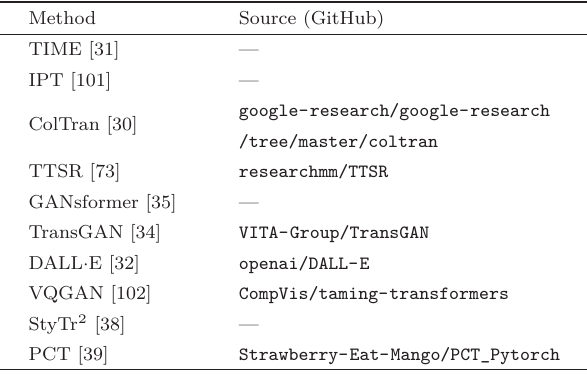
tasks, as listed in Table 4. Low-level vision tasks include super-resolution [101], denoising [101], image Table 4 Source code links for ViT-based models for low-level vision tasks